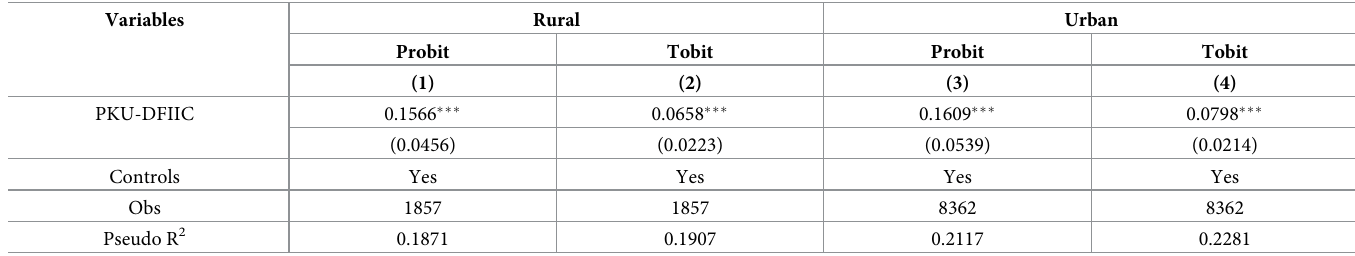
Table 6. Heterogeneity analysis 3: Household location.